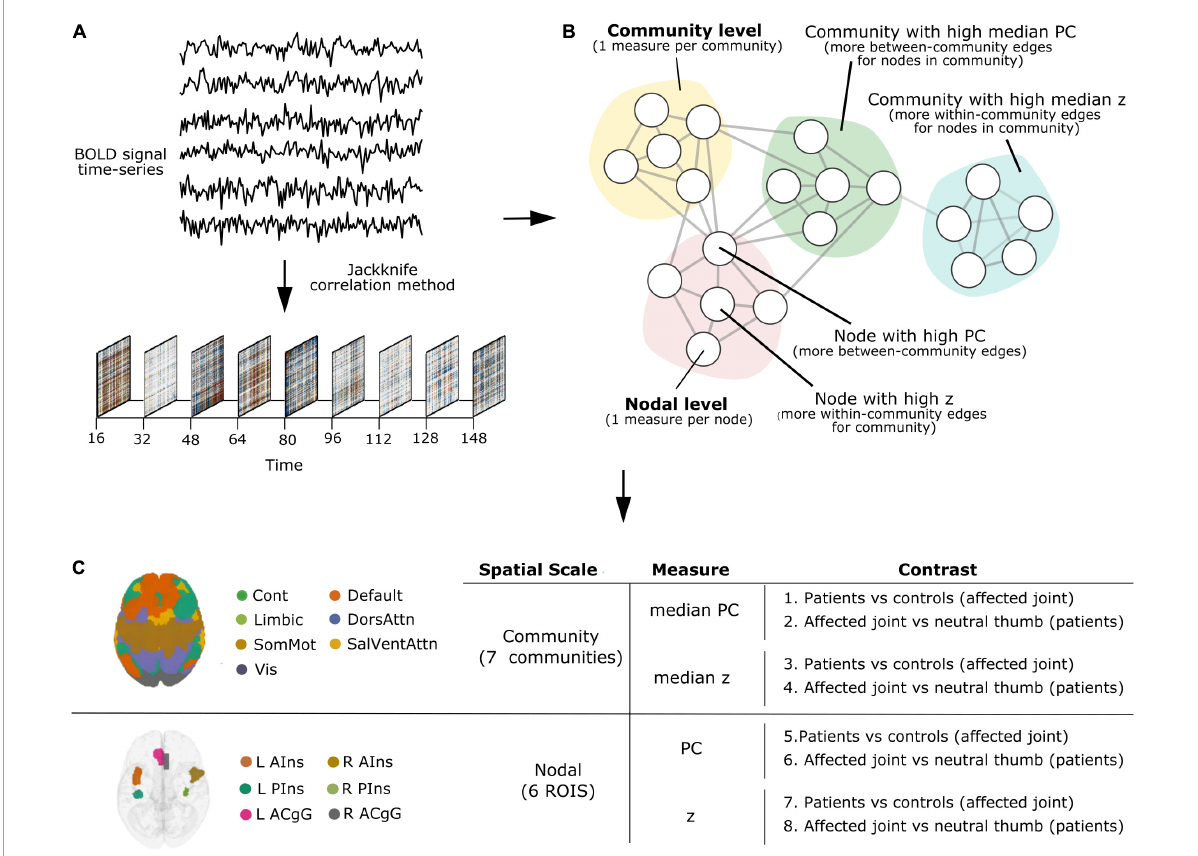
FIGURE1 A schematic representation of the time-varying functional connectivity (TVC) analysis steps undertaken in this work. (A) BOLD signal time-series were extracted from brain regions defined using the 7-network, 400-node Schaefer parcellation scheme (Yeo et al., 2011; Schaefer et al., 2018) and TVC was computed at the level of single time points using the jackknife correlation method (Richter et al., 2015). (B) Measures of integration (participation coefficient, PC) and segregation (within-module degree z -score, z ) were quantified and used at the level of single nodes (brain areas, nodal level) and communities (clusters of nodes, community level). (C) Analyses were carried out at the community and nodal level, separately. Within each level, we examined how the degree of integration (PC) and segregation ( z ) varies over time and whether this is influenced by painful stimulation to the joint across groups (Contrasts 1, 3, 5, 7) and based on the stimulation site in patients (Contrasts 2, 4, 6,